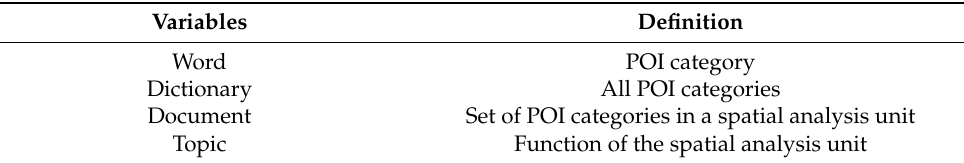
Table 1. Definition of the LDA variables in this study.